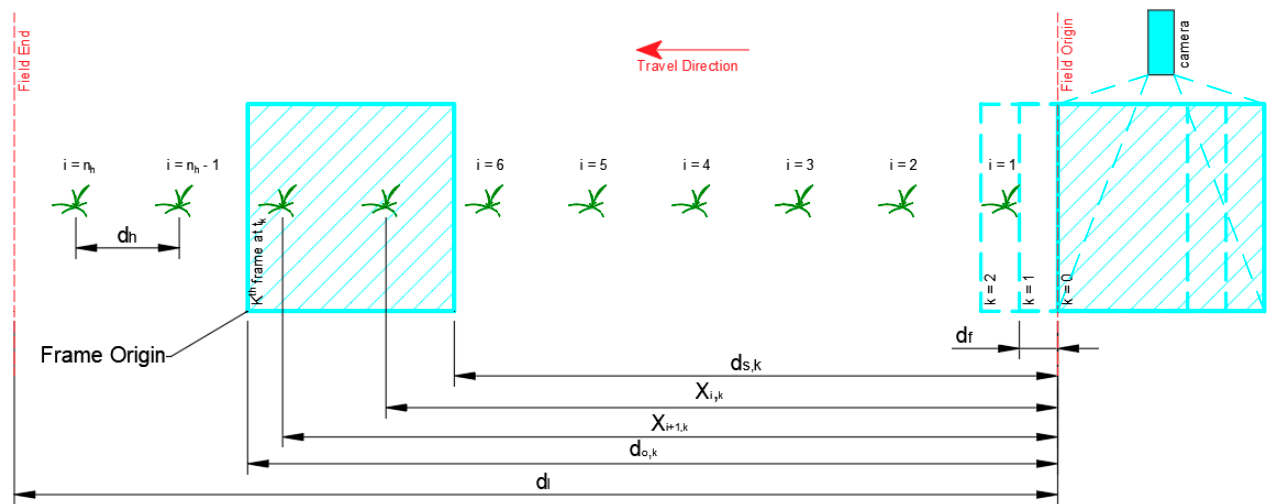
Figure 4. Virtual field with field map and motion modeling parameters. The frame at k = 0 represents the frame just outside the virtual field. The frame at k = 1 represents the first frame that entered the virtual field.